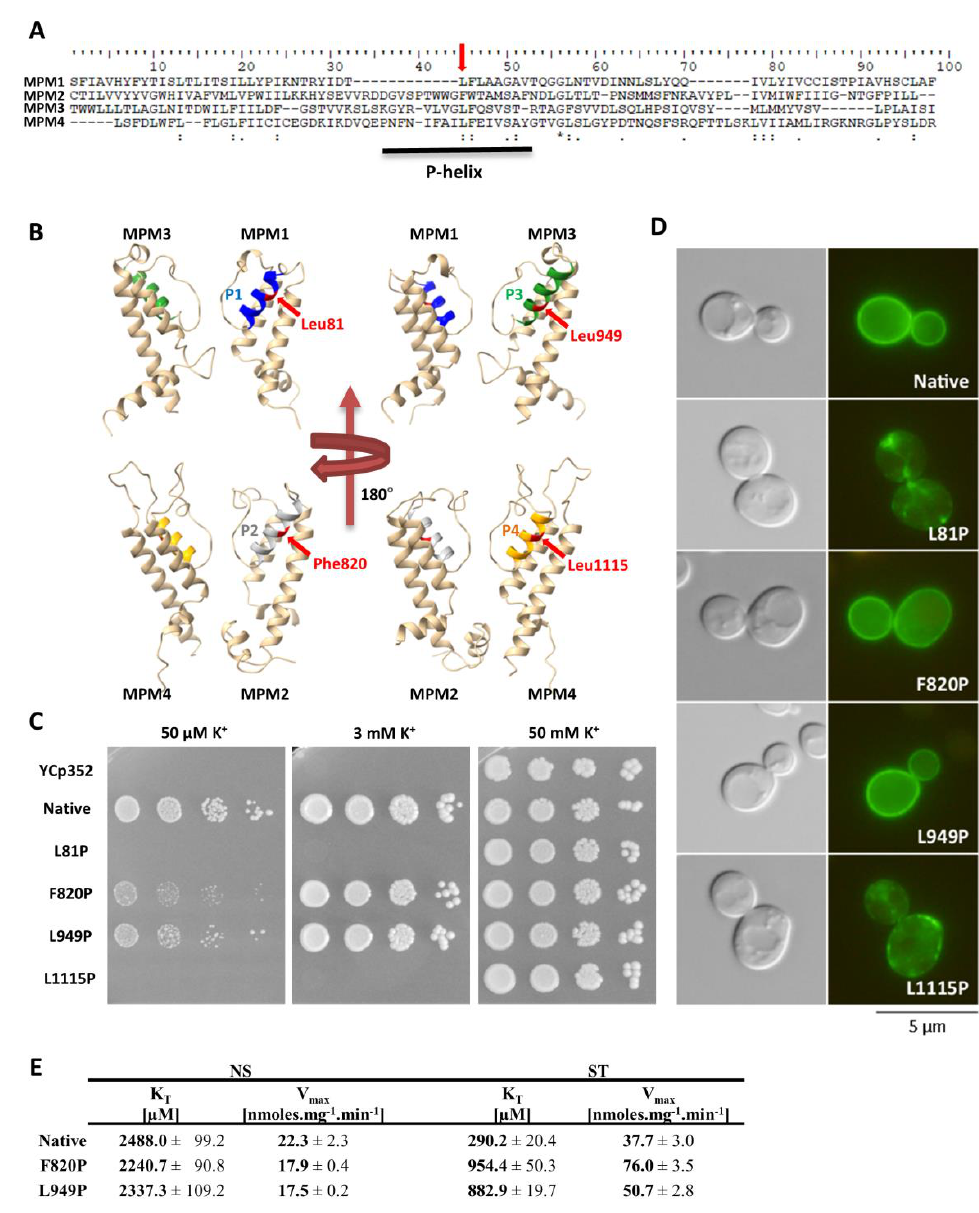
Figure 5. Effects of introduction of proline into P-helices. ( A ) Sequence alignment of Trk1’s MPM domains 1–4. Leu949 and corresponding amino acids in MPM 1, 2 and 4 are indicated with red arrows. P-helices within MPM domains are underlined. ( B ) Positions of amino acids Leu81, Phe820, Leu949 and Leu1115 within 3D model of Trk1 protein. P-helix 1 is highlighted in blue, 2 in grey, 3 in green and 4 in orange. Studied amino-acid residues are shown in red. For better clarity, only two opposing MPM domains are shown. ( C ) Growth of BYT12 cells without TRK1 (BYT12 [YCp352]) or with centromeric vector harbouring TRK1 (native) and its mutated versions on YNB-F plates supplemented with K + as indicated. Images were captured after 5 days of incubation at 30 ◦ C. ( D ) Localisation of GFP-tagged Trk1 and its mutated versions in BYT12 cells. Cells were grown and viewed as described in Section 2. ( E ) Kinetic parameters of native Trk1 and its mutated versions after 3 h of K + starvation. Both non-starved (NS) and starved (ST) cells were grown as described in Section 2. ST cells were incubated in a YNB-F for an additional 3 h. Rb + uptake was measured and kinetic parameters were estimated as described in Section